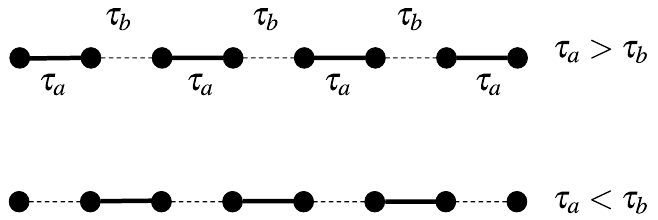
Figure 4. Sketch of the hopping bonds in the Hubbard chain, Eq. (20), with non uniform alternating τ a and τ b .